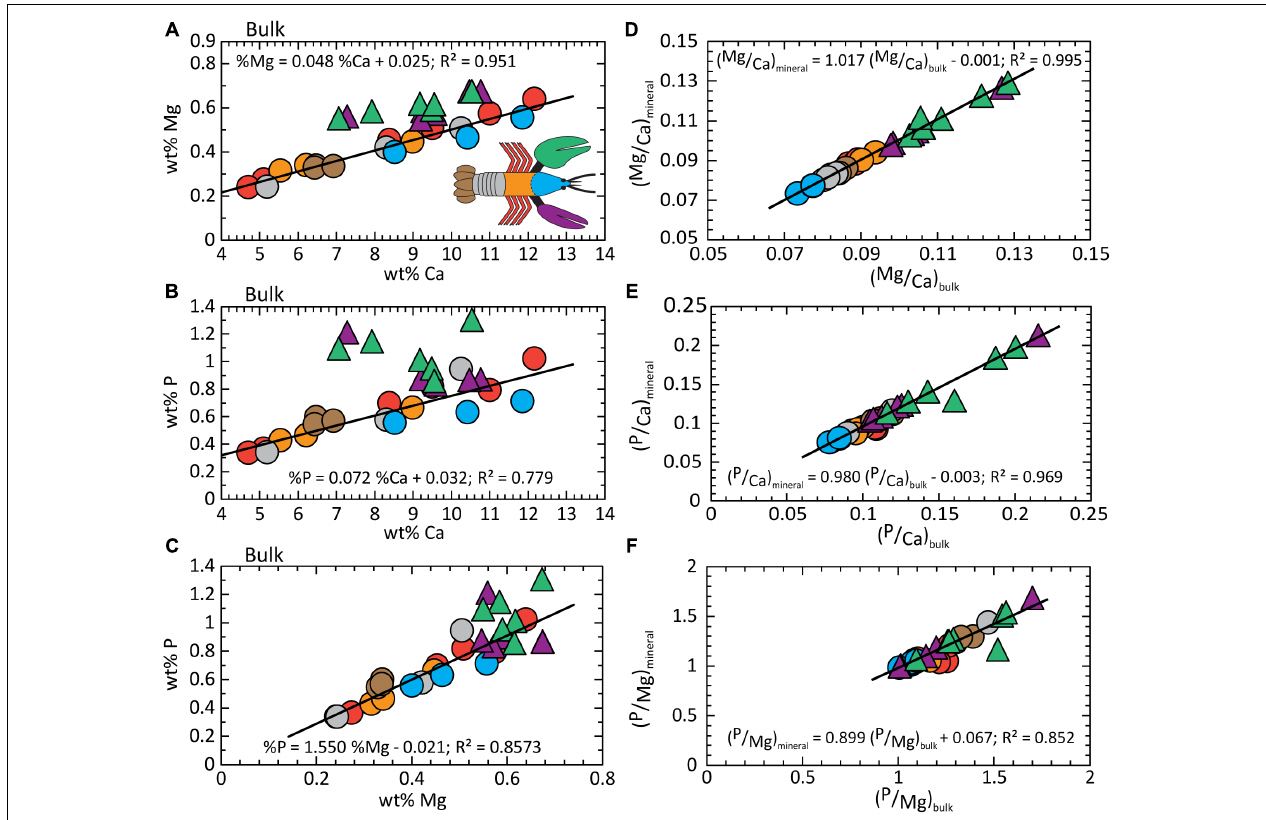
FIGURE 5 | Composition analysis of the bulk exoskeleton. (A) wt% Ca vs. wt% Mg; (B) wt% Ca vs. wt% P; (C) wt% Mg vs. wt% P. The 1:1 relationship between element ratios in the mineral fraction versus bulk exoskeleton demonstrates bulk composition is dominated by the contributions from the mineral. (D) Mg/Ca; (E) P/Ca; and (F) Mg/P. Detailed statistics are given in Supplementary Table S3